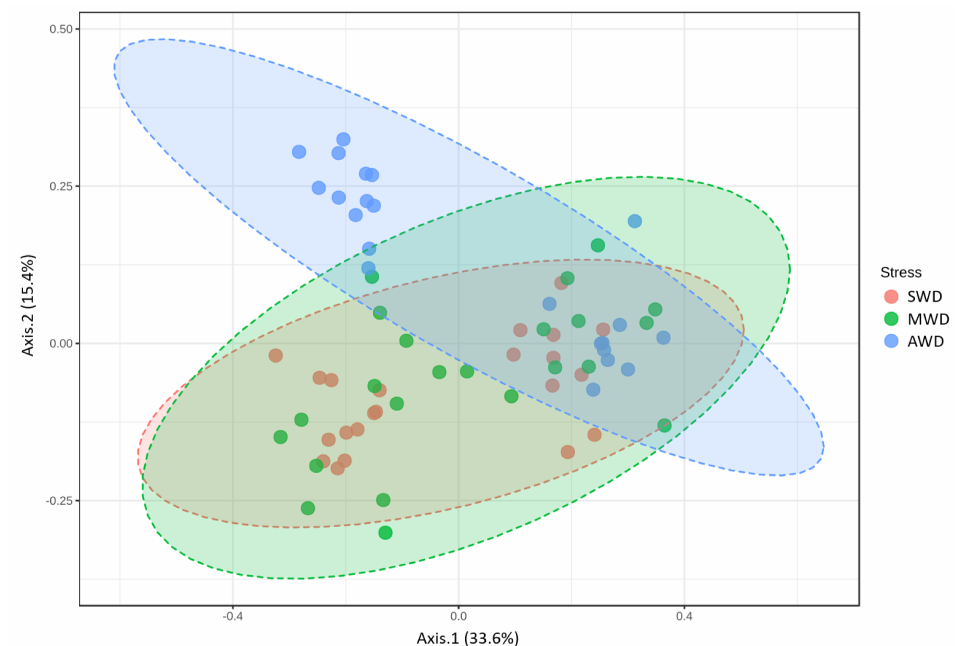
Figure 5. Principal Coordinate Analysis (PCoA) based on Bray–Curtis dissimilarity metrics, showing the distance in the fungal communities among irrigation regimes (SWD: severe water deficit, MWD: moderate water deficit, and AWD: absence of water deficit), at both sampling times of the fungal communities in the